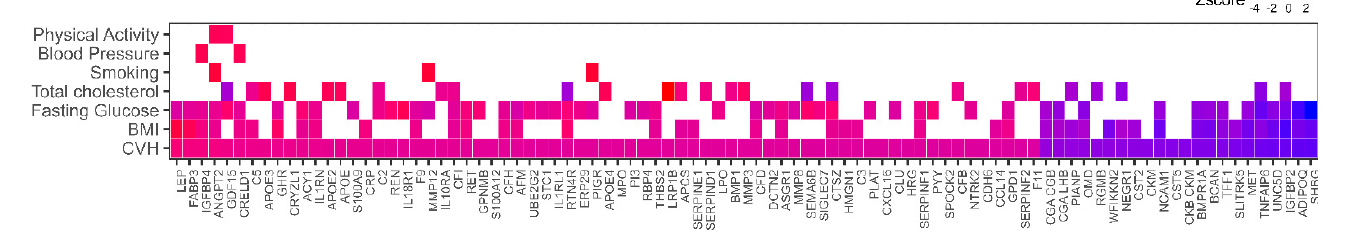
Values represent mean (SD), or n (%).